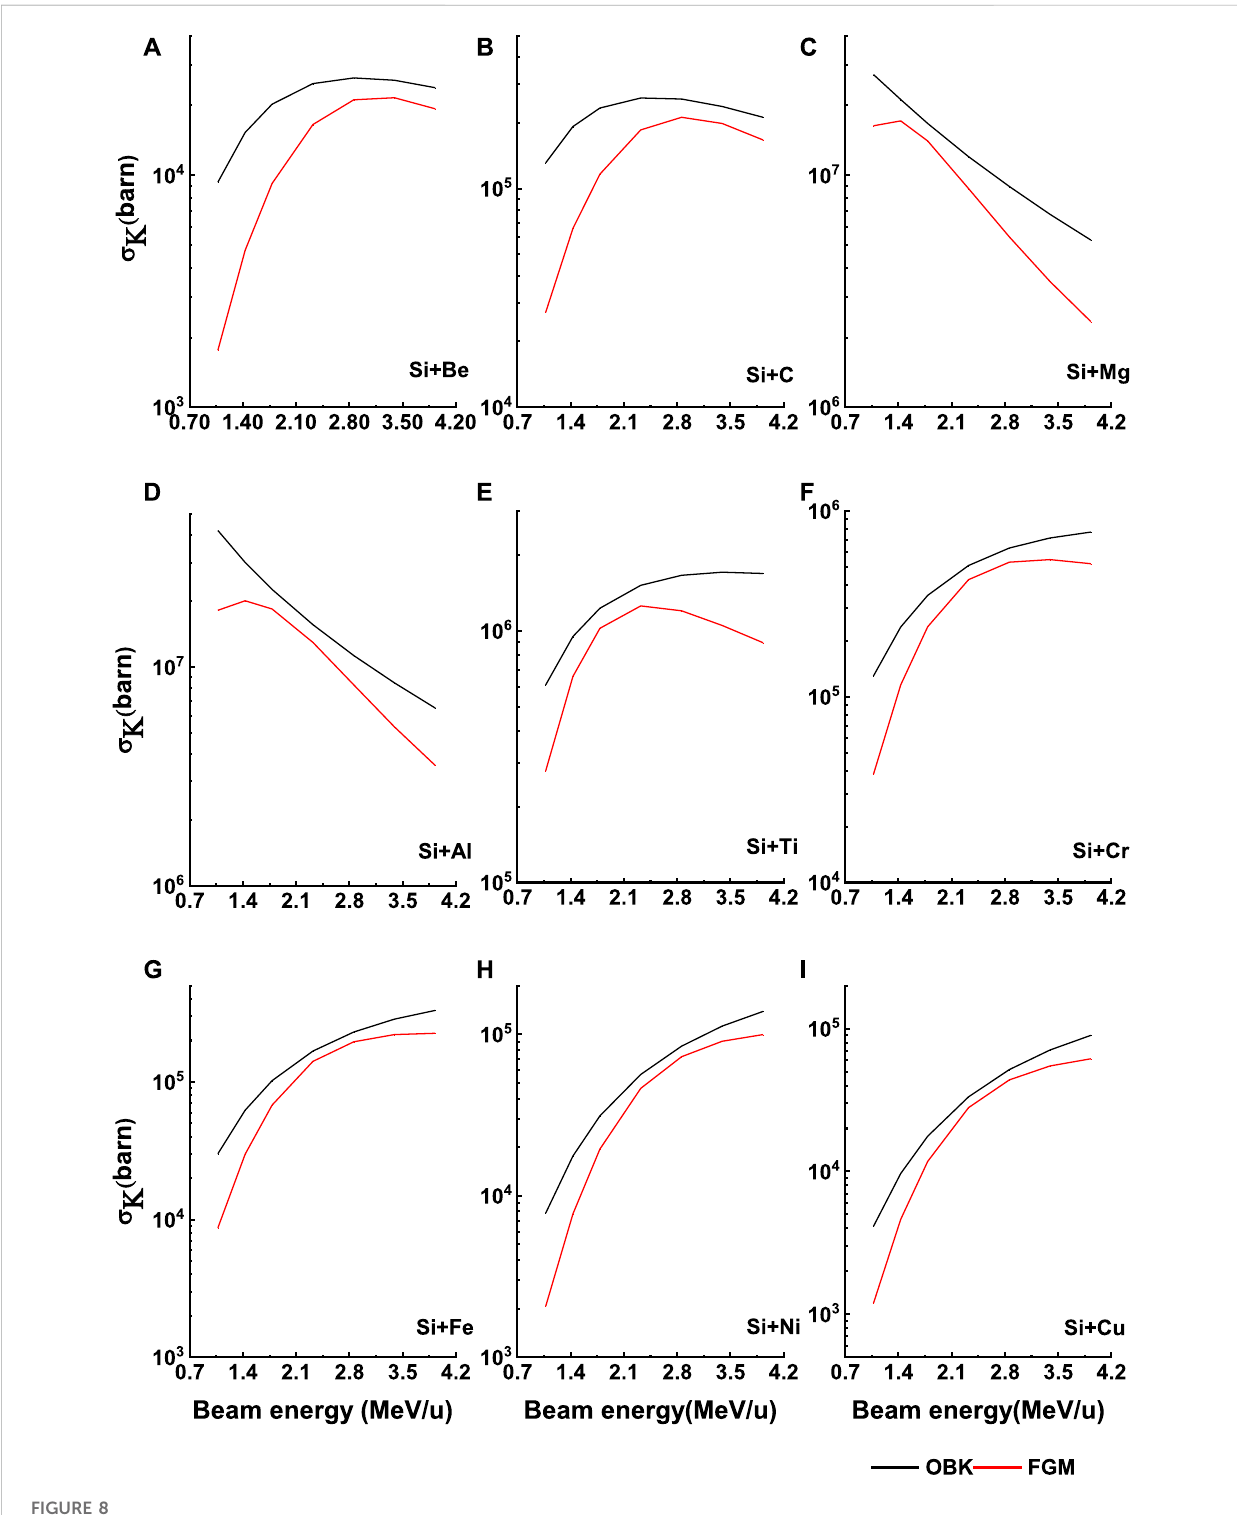
FIGURE 8 TheelectroncapturecrosssectionsobtainedfromOBKapproximationandF-G-Mpredictionfordifferenttargets(fromBetoCu)bombardedbySi 28 ions as a function of ion beam energies (A-I) . The solid lines are to guide the eye